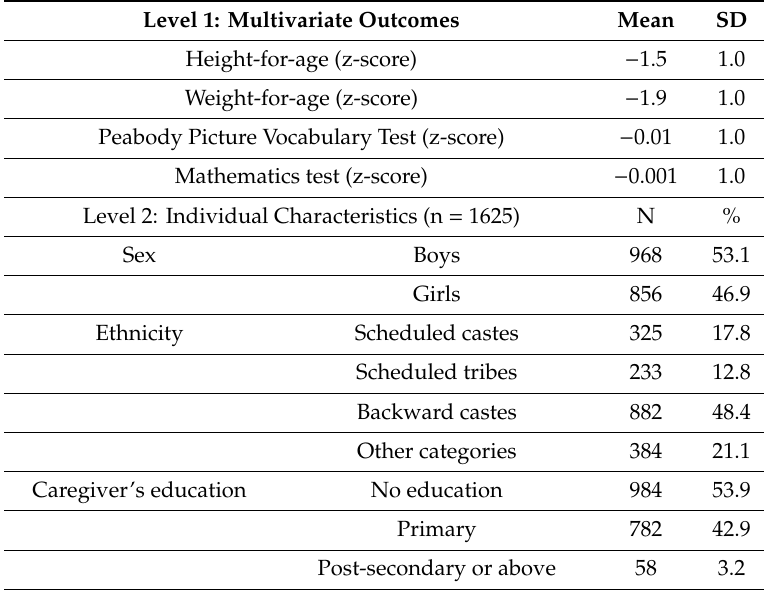
Table 1. Information for 5-year-old children’s individual / family backgrounds and community characteristics in Andhra Pradesh, India from Young Lives 2006.